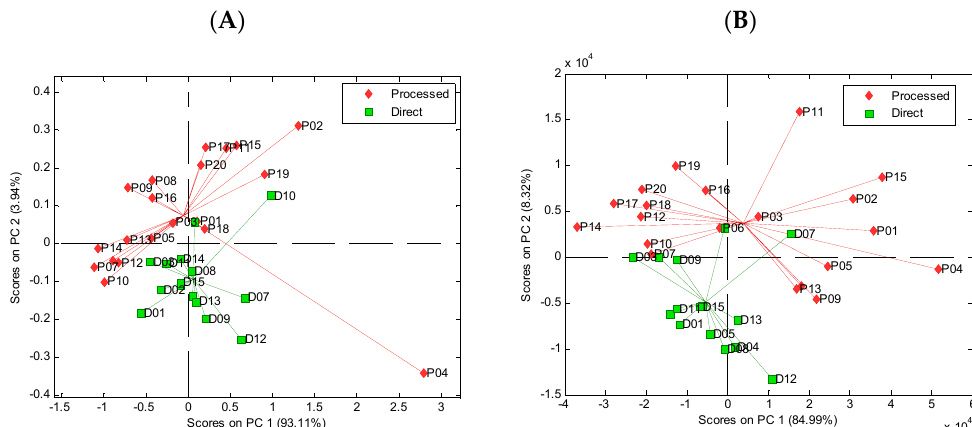
Figure 5. Score plots of PCA analysis of fresh and commercial strawberry juice based on the UV–vis absorption spectra ( A ) and unfolded excitation–emission matrices (EEMs) ( B ).